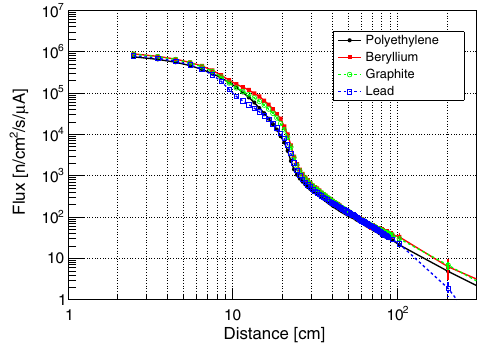
Figure 5: Thermal neutron flux as a function of the dis- tance, for di ff erent reflector material. In this configura- tion a 10 cm thick reflector material is placed around a ∼ 15x15x20 cm 3 polyethylene